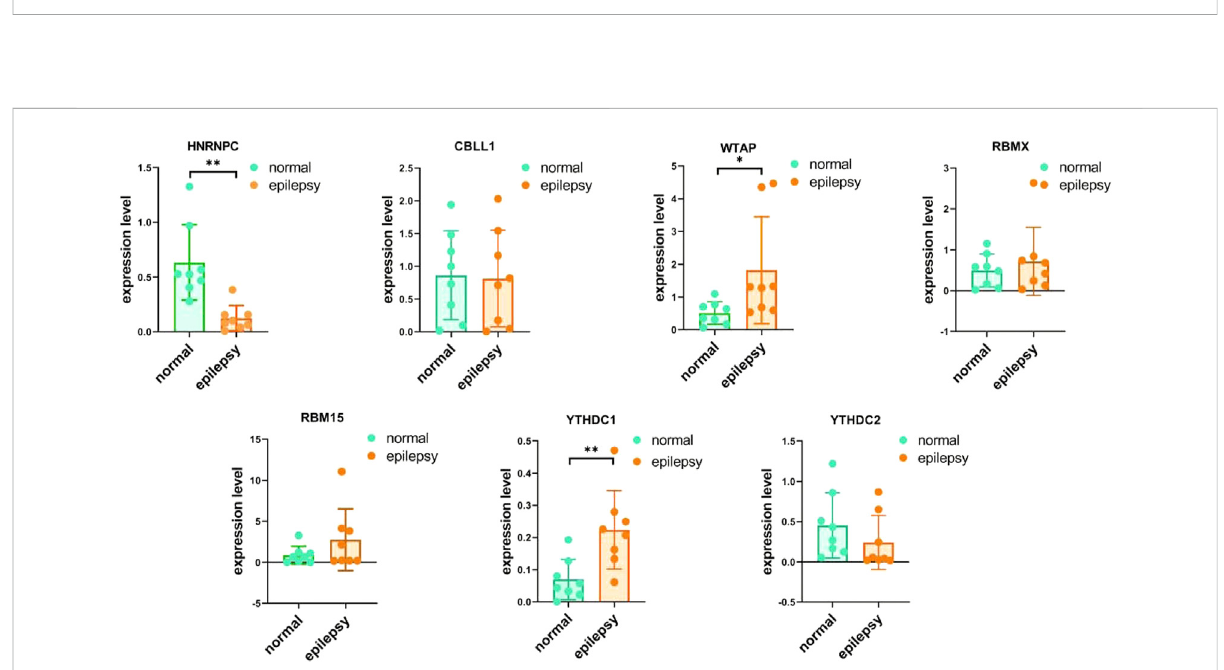
FIGURE 12 IRNA expression of seven M6A-related genes were measured in primary epilepsy and healthy samples. RNA expression of HNRNPC, CBLL1, WTAP,RBMX,RBM15,YTHDC2,andYTHDC1weremeasuredinbloodsamplesusingqRT-PCR. p -valueswerecalculatedusingatwo-sidedunpaired Student ’ s t -test. *13 < 0.05 ** p <